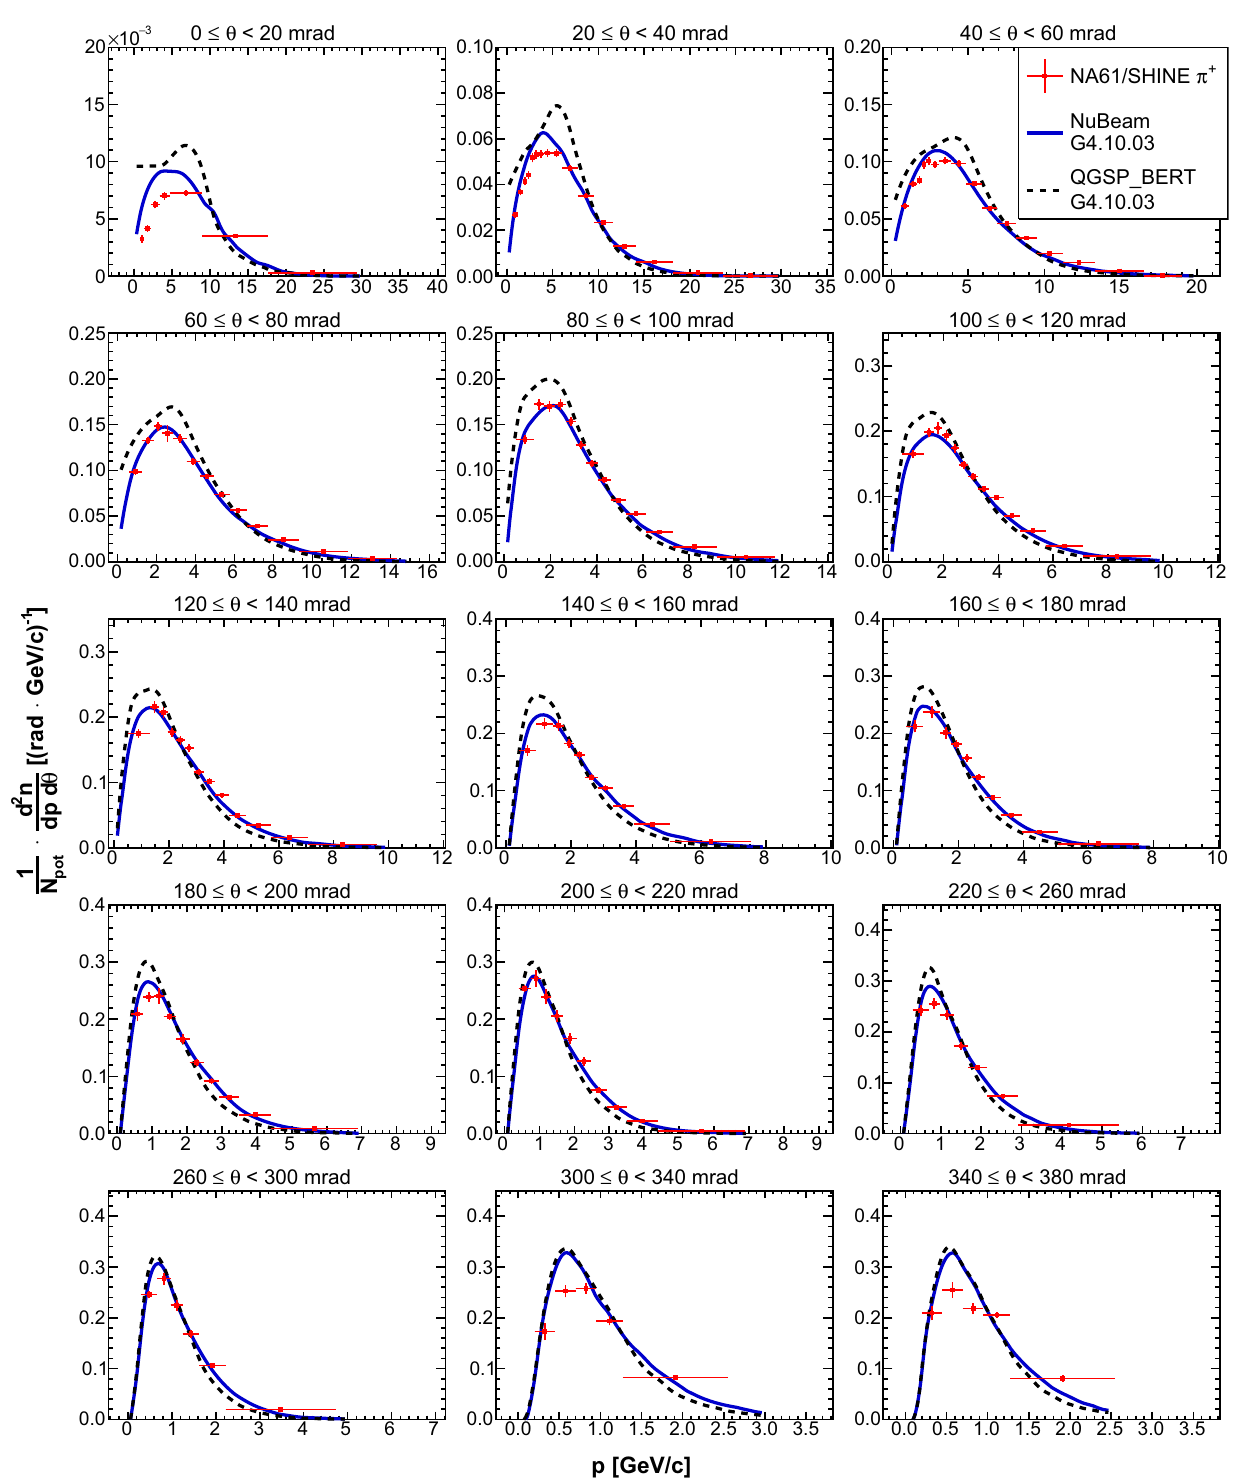
Fig. 27 Double differential yields of positively charged pions for the fifthupstreamlongitudinalbin(72 ≤ z < 90cm).Verticalbarsrepresent the total uncertanties. Predictions from the NuBeam (solid blue line)